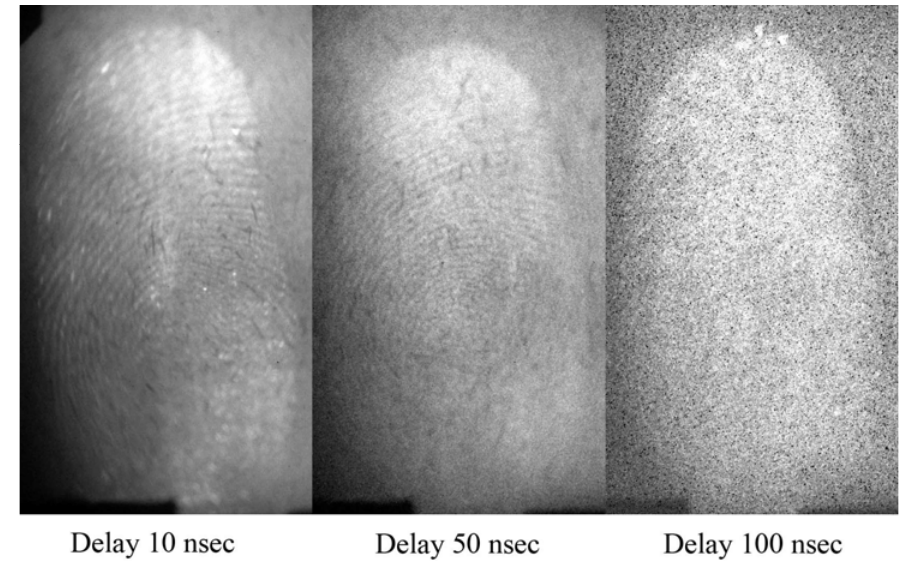
FIGURE 4. Time-resolved fluorescence images of latent fingerprints on a HG white paper with a band-pass filter excited with 266 nm.